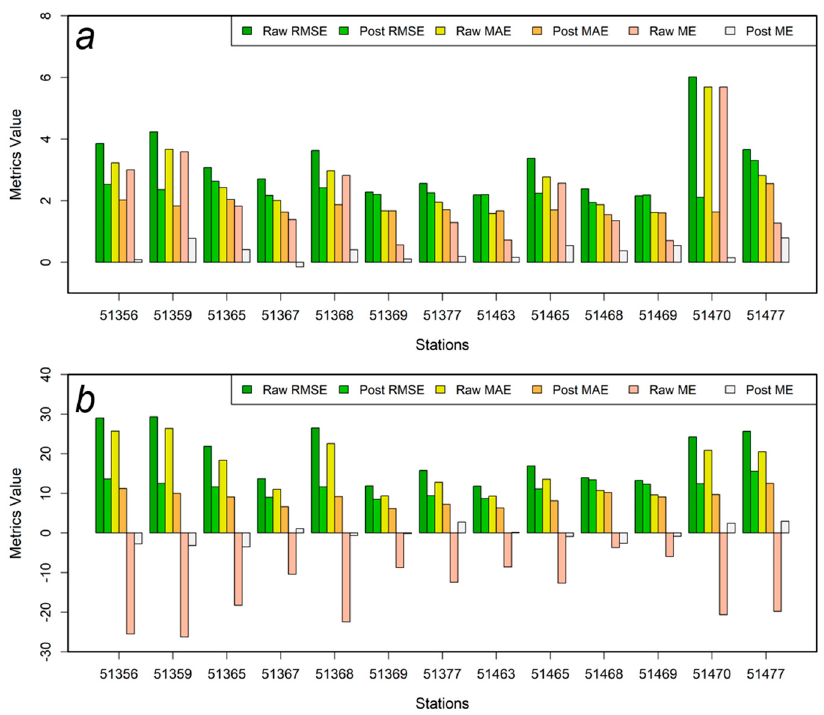
Figure 6. Forecast performance of raw forecast and post-correction results for: ( a ) temperature and ( b ) relative humidity.